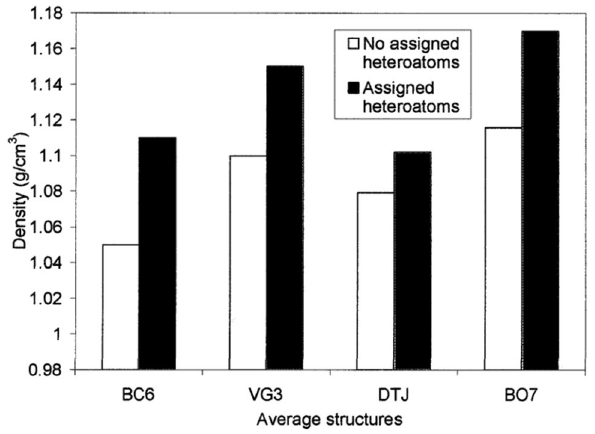
Fig. 7 Effect of heteroatoms on density